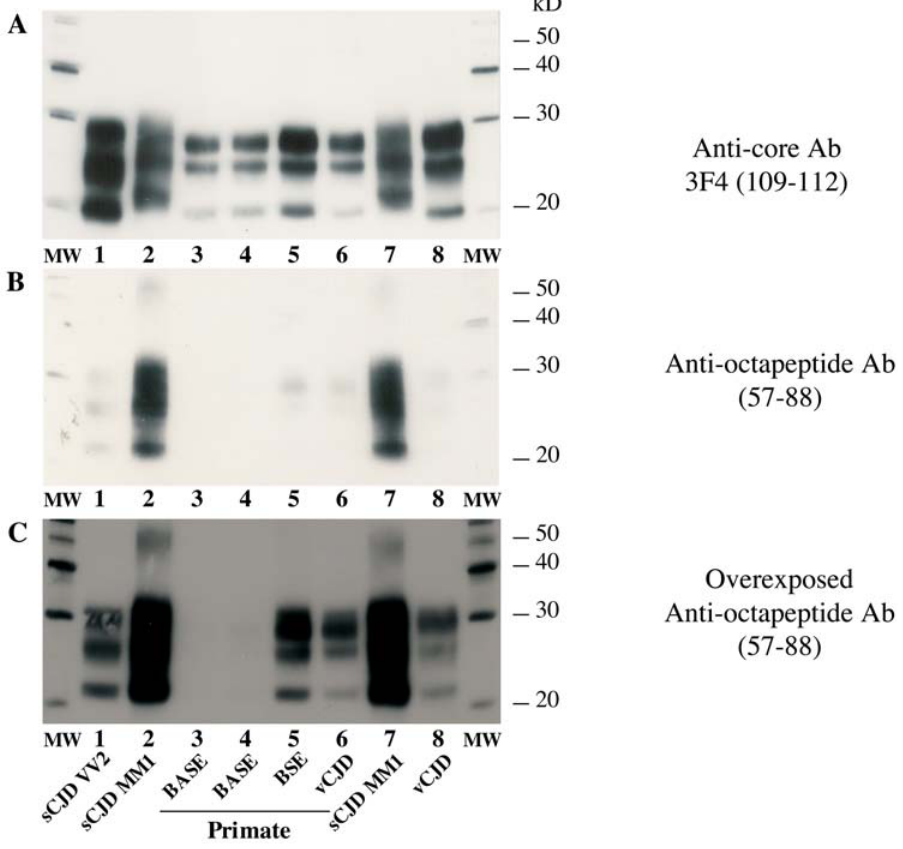
Figure 3. Electrophoretic analysis and differential sensitivity to proteolysis of PrPres in various prion diseases of primates and humans. PrPres from brain homogenates (MM1 or VV2 sCJD, vCJD in humans, or primates experimentally infected with BASE, cBSE or vCJD inocula) were purified under high concentrations of proteinase K, and detected with monoclonal antibodies recognizing either the core (3F4, panel A) or the octapeptide region (panel B and C) of the protein. Frontal cortex and obex regions of BASE-infected primate were both analysed (lanes 3 and 4 respectively). Panel C is an overexposure of the autoradiography of Panel B to detect weak signals. The absence of octarepeat region reactivity in the PrPres of the BASE in Panel C indicates a proportion at least ten fold lower than that of the vCJD or cBSE samples on the basis of a quantitative analysis of chemiluminescence signal intensities.